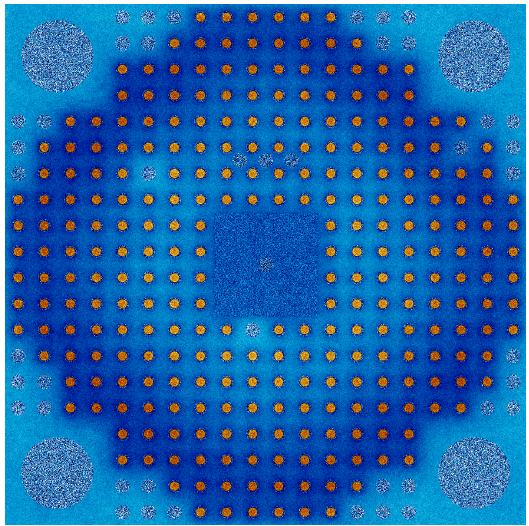
Figure 1: Yalina-Thermal 3D-view blueprint [9] located within the assembly core: EC1 (core center), EC2 (core middle part) and EC3 (core periphery). The Yalina- Thermal 3D-view blueprint is shown on figure 1. The main parameters are presented in table 1. Table 1: Yalina-Thermal assembly main design character- istics Figure 3: k e ff calculations